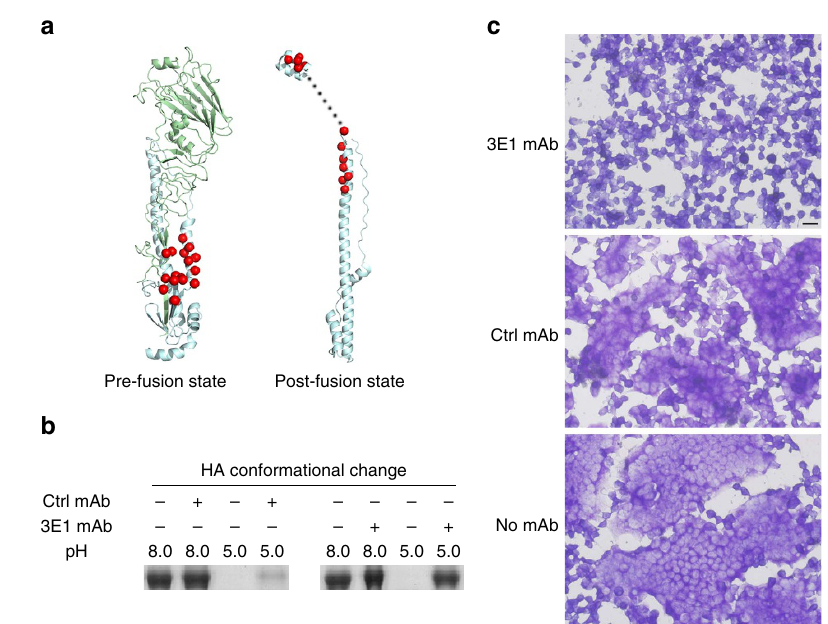
Figure 6 | 3E1 inhibits low-pH-induced HA conformational change. ( a ) Location of the residues forming the 3E1 epitope in the pre-fusion-state monomeric HA (left panel; PDB code: 3LZG) and post-fusion-state monomeric HA (right panel; PDB codes: 1QU1 and 2KXA). The residues of the epitope are shown as red spheres. ( b ) Protease sensitivity assay of HA in the presence of 3E1 mAb. Exposure of HA to low pH converts the HA to the protease-susceptible, post-fusion state (lanes 3, 7). Treatment of HA with 3E1 mAb before low-pH treatment, but not the control mAb, blocks the pH-induced conformational change, retaining HA in the protease-resistant, pre-fusion state (lanes 4, 8). Data represent a representative experiment from three independent experiments. ( c ) 3E1 mAb blocks trypsin-activated, low pH-triggered, HA-mediated cell–cell fusion. HEK-293T cells were transfected with full-length WA11 HA and treated with trypsin, and then 3E1 or control mAb was added followed by low-pH treatment. Treatment of 3E1 mAb could inhibit the formation of syncytium (upper panel), while the control mAb could not (middle panel). Scale bar represents 20 m m. Data represent a representative experiment from three independent